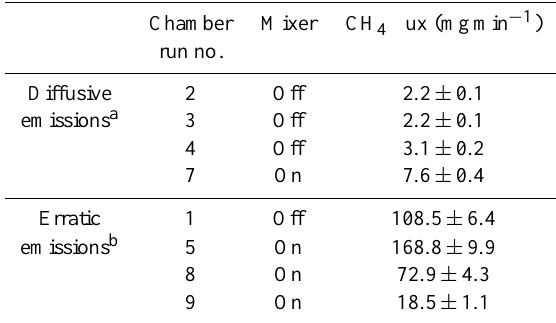
Table 2. Fluxes measured during chamber measurements on the clarification